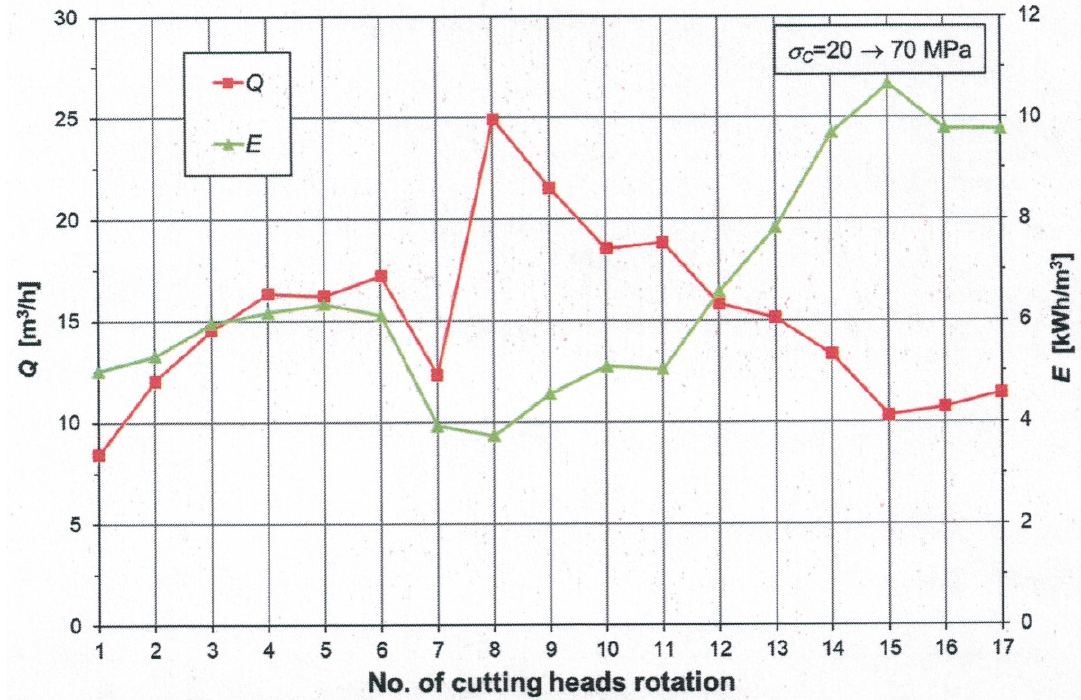
Figure 14. ( a ) Time courses of dynamic load on the motor shaft in the cutting heads drive ( T ) and its angular velocity ( 𝜑(cid:4662) ) and ( b ) values of parameters characterizing this load in subsequent rotations of the cutting heads during the performance of lower cut in the automatic control mode in rocks with increasing uniaxial compressive strength.